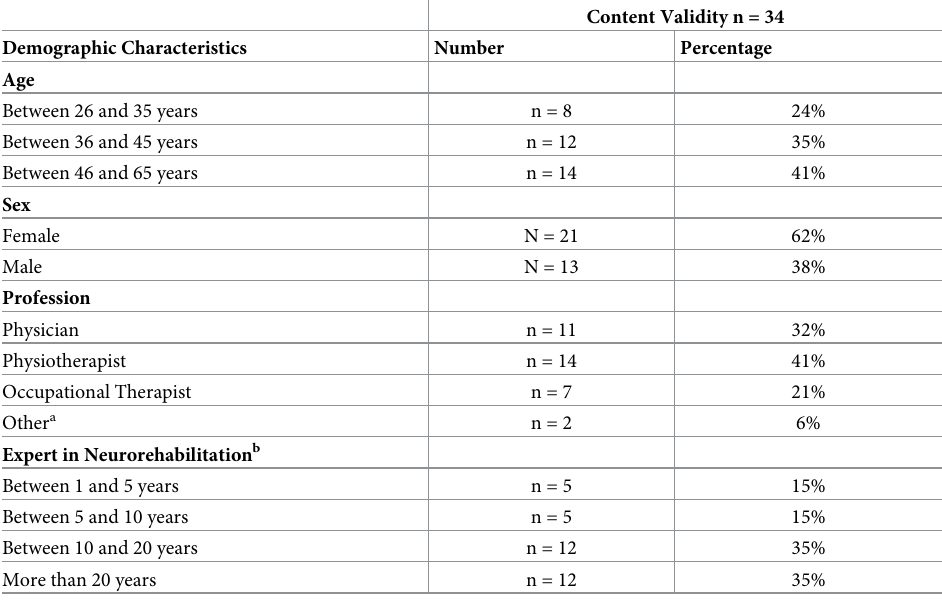
Table 2. Demographic characteristics of participants in content validity.